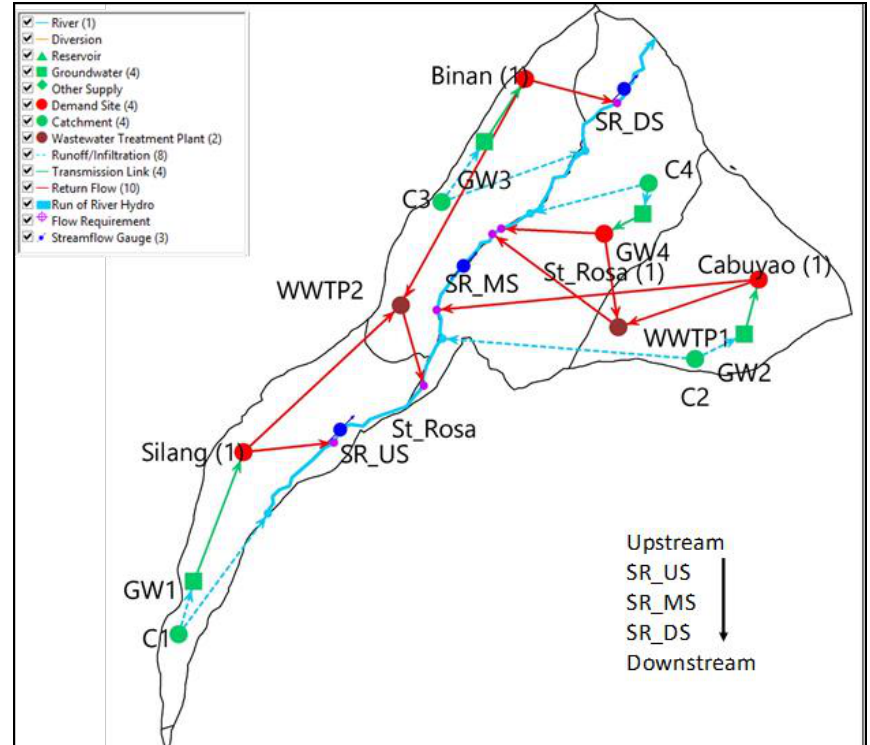
Figure 3. Schematic diagram showing the problem domain for water quality modeling in Santa Rosa plant, SG—Stream gauge, C—Catchment,